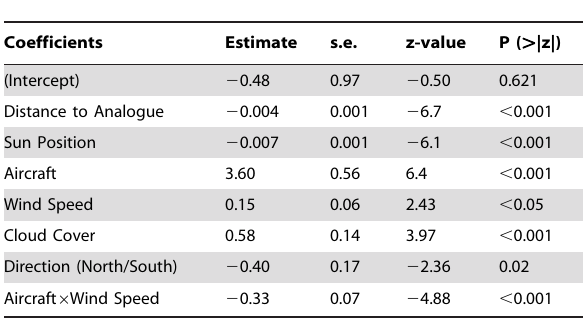
Table 2. Logistic regression analysis examining the effects of aircraft type, distance to analogue and various environmental variables on analogue sightings per